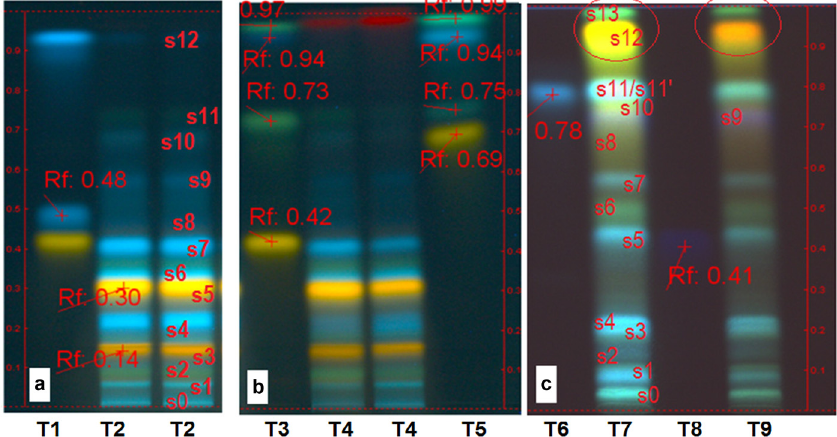
Figure 2: ( HP ) TLC studies on the polar extracts from A. nemorosa